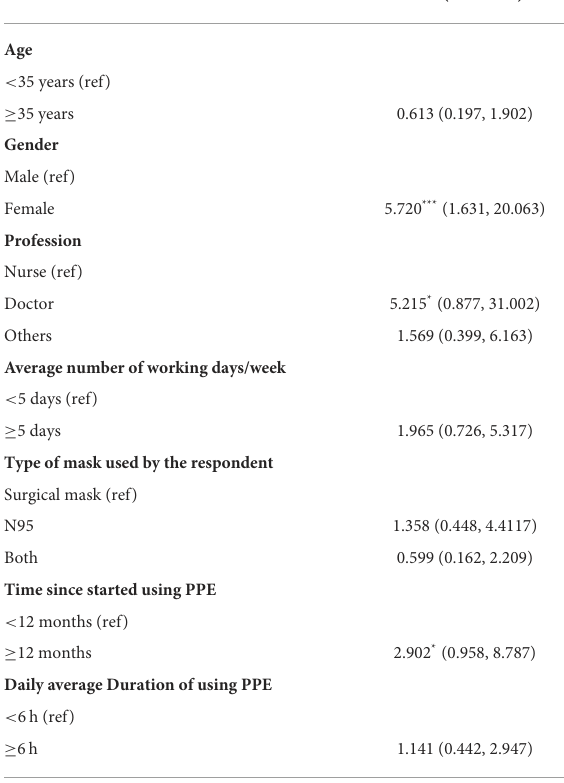
TABLE 5 Logistic regression coefficients and odds ratios (95% CI) for determinants adverse